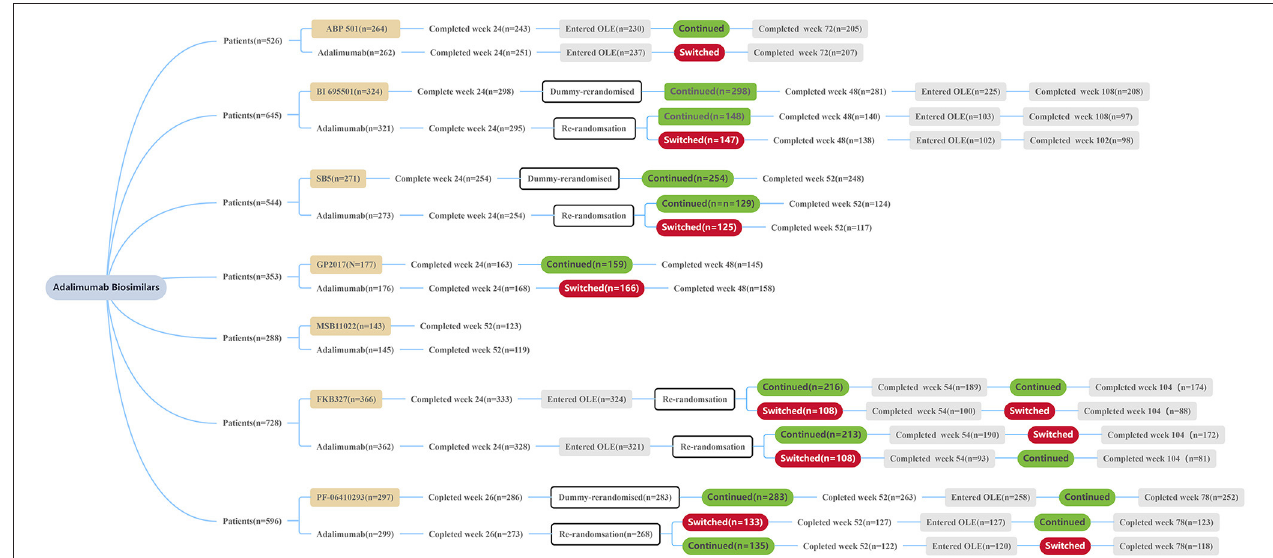
FIGURE 1 | Patient disposition summary of each trial. All patients received ADL or a biosimilar at a dose of 40 mg/0.8mL solution subcutaneously every other week during the treatment period. OLE, open label extension.